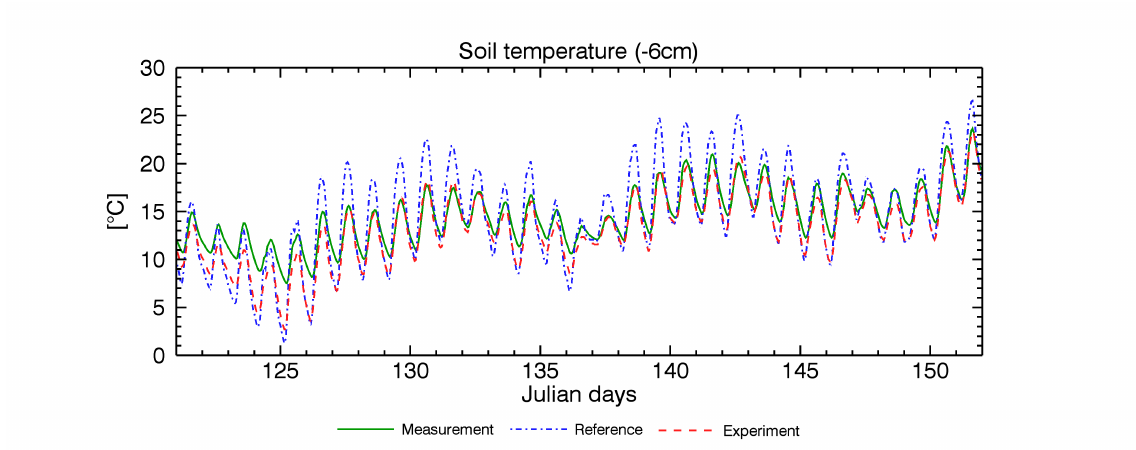
Figure 10. Same as Figure 8 but for the soil temperature at a depth of 6